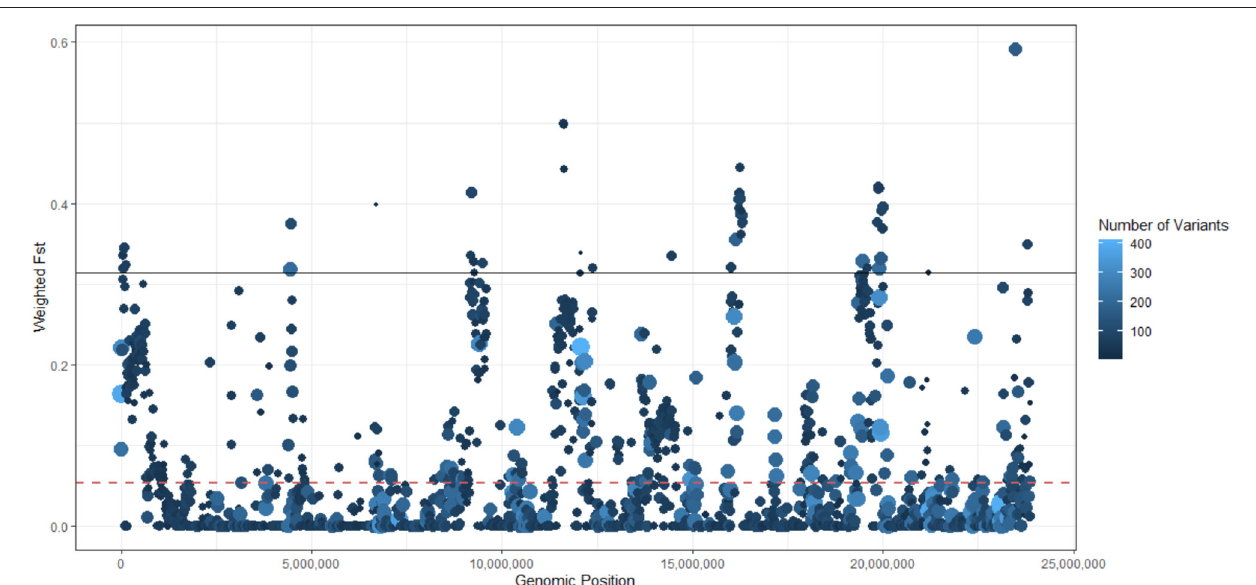
FIGURE 3 | Sliding window analysis of population differentiation of Batrachochytrium dendrobatidis ( Bd ) isolates (PA1 and PA2) against other 45 global panzootic lineage of Bd ( Bd GPL) isolates using Weir and Cockerham’s F ST estimator. Each point represents a 10Kb genomic window, with a 5kb step-size. The dashed red line represents the mean F ST (0.0538). The solid black line represents the 95% quantile threshold of the F ST estimator (0.3141). Each point is sized and colored on a log scale by the number of variants in each window. The legend indicates the color scale (the number of SNPs included in each window varied from 1 to 364, with a median of 31). Point size from small to large is scaled from low to high numbers of variants.